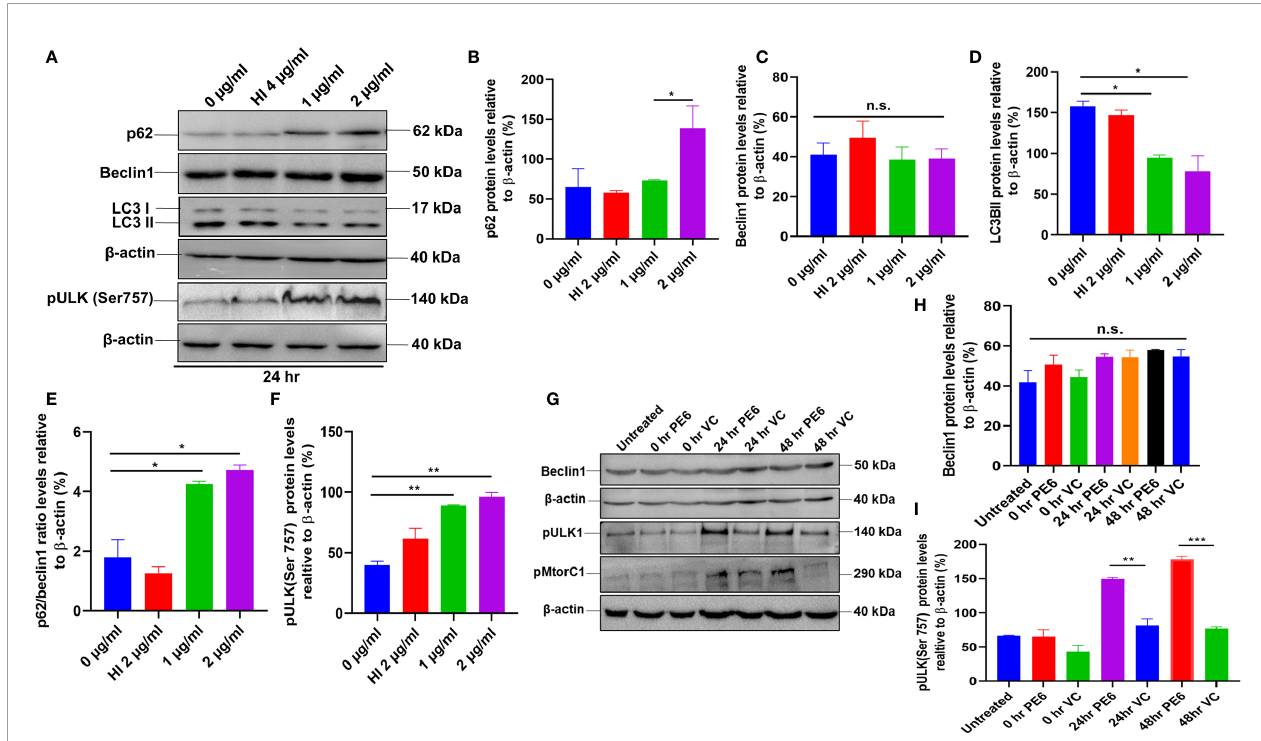
FIGURE 7 | PE6 inhibits autophagy in treated RAW264.7 cells. (A) Western blots demonstrating the inhibitory effect of PE6 on cellular autophagy of RAW264.7 macrophage cells utilizing autophagy markers p62, Beclin1, LC3BII, and pULK1. RAW264.7 macrophage cells were treated with different concentrations of PE6 (1 and 2 µg/ml) for 24 h. The cell lysate was prepared, run in SDS-PAGE, proteins were transferred onto the PVDF membrane and probed with indicated antibodies. Untreated and HI-treated cells were used as negative controls. (B – F) Densitometric quanti fi cation of the protein bands (p62, Beclin1, LC3BII, and pULK1, and the ratio of p62/Beclin1) are shown. Protein levels were represented as [%] to b -actin. (G) Western blot demonstrating the levels of autophagy markers Beclin1, pULK1, and pMtorC1 after infection with recombinant M. smegmatis to RAW264.7 macrophage cells at MOI of 1:10 for 24 and 48 h. b -actin was used as a loading control. Uninfected and vector-alone transformed cells were used as negative controls. (H, I) Densitometric analysis of Beclin1 and pULK1 levels relative to b -actin. Protein levels were represented as [%] to b -actin. Data were analyzed by one-way ANOVA with Tukey ’ s multiple comparison post-test. Data are representative of two independent experiments. *P < 0.05, **P < 0.01, ***P < 0.001 vs . controls. n.s; difference not signi fi